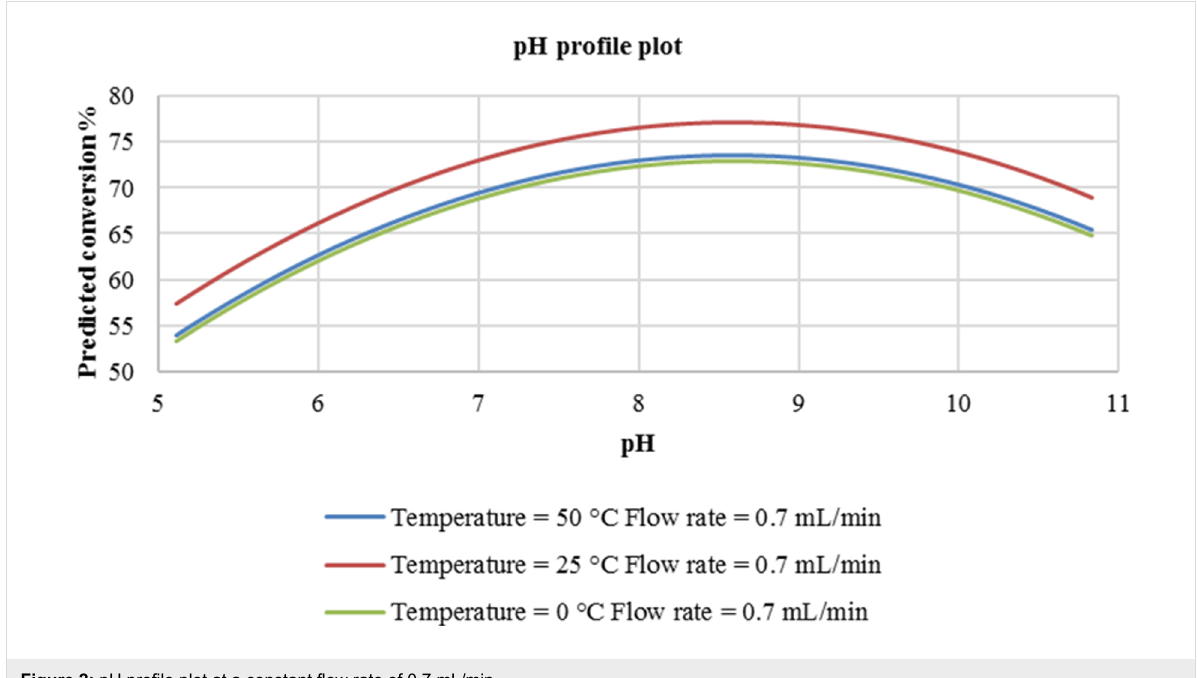
Figure 2: pH profile plot at a constant flow rate of 0.7